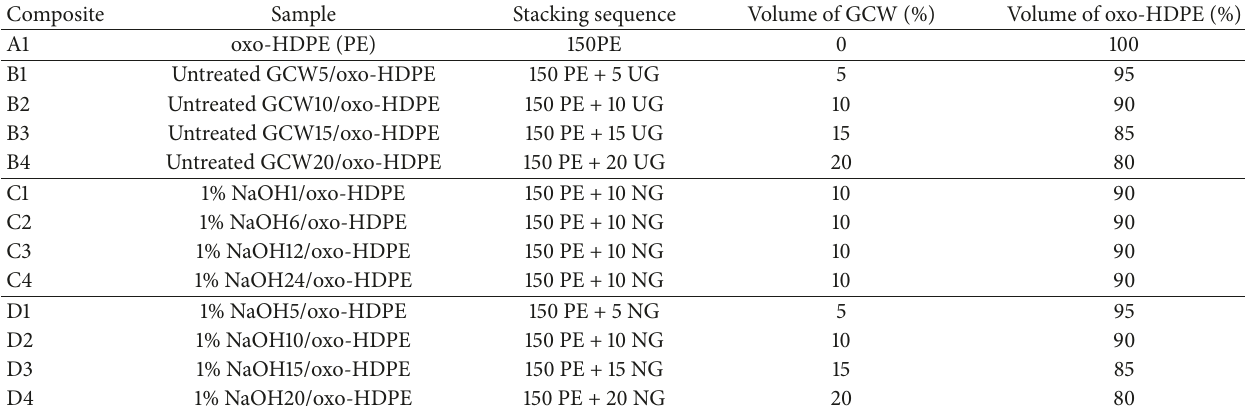
Table 1: Summary of the composites investigated in this